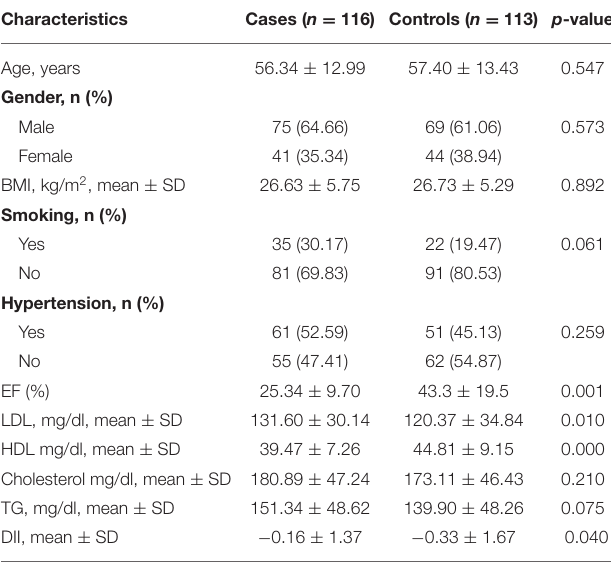
TABLE 1 | Characteristics of patients in the case and control groups ( n = 229).